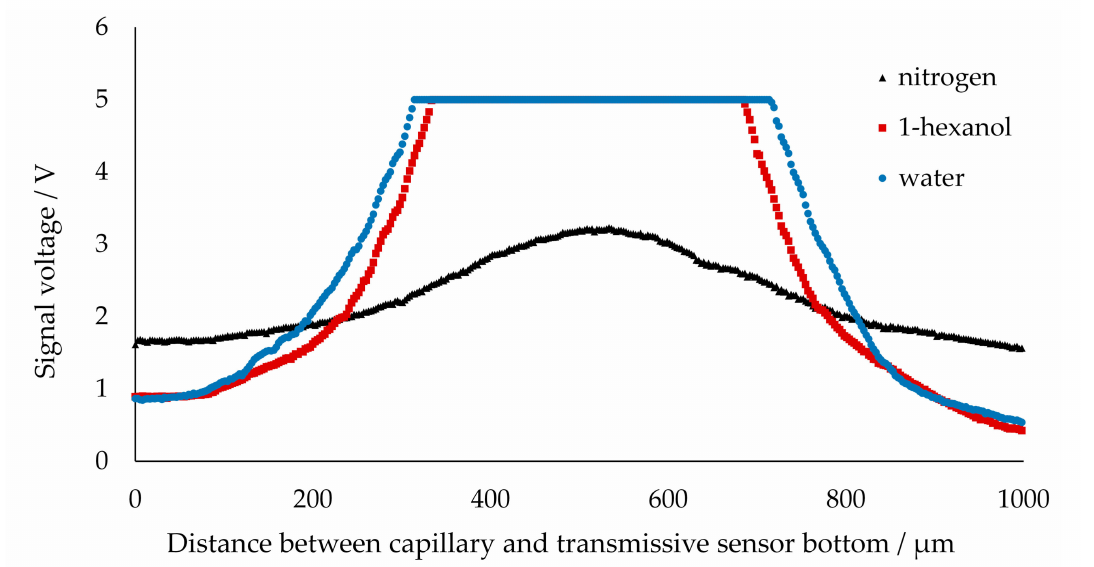
Figure 5. Measured voltage from phototransistor for a single-phase 1-hexanol-filled capillary and water or nitrogen bubble with uniform capillary vertical displacement using a step